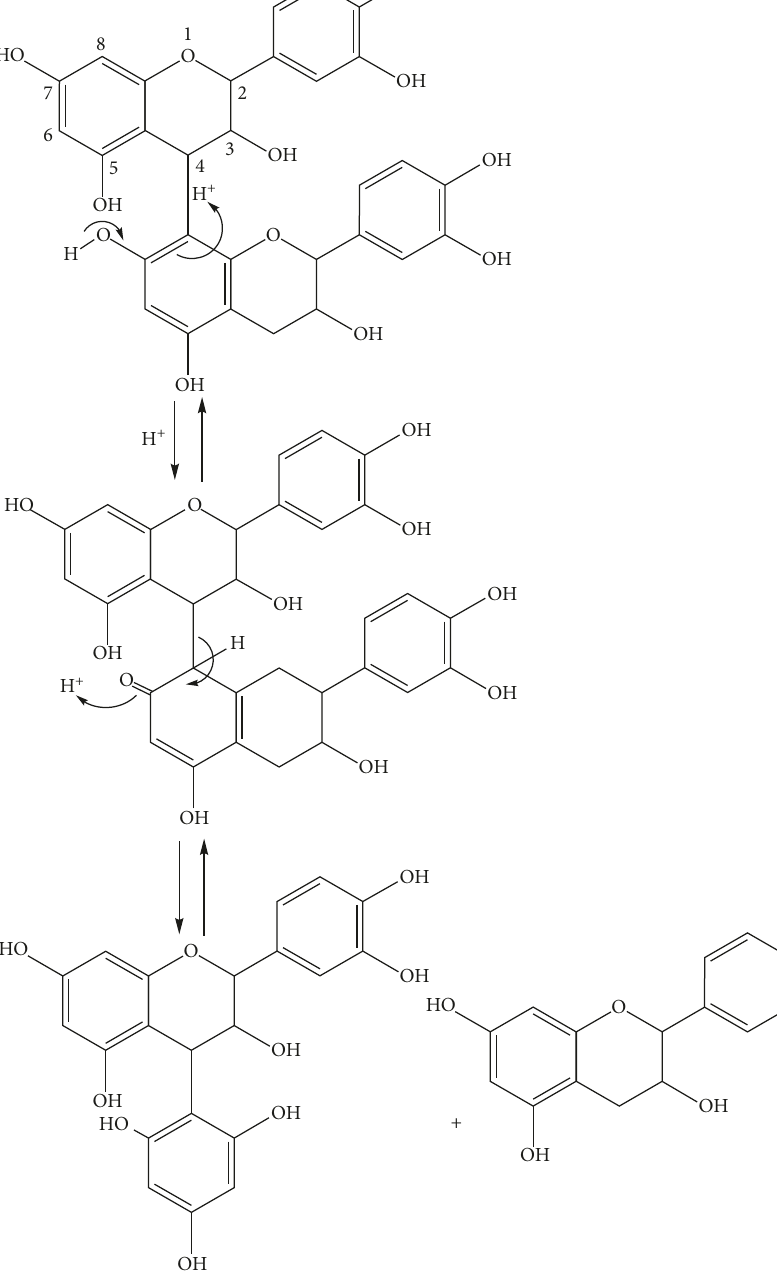
Figure 1: Reaction mechanism of acid-catalyzed hydrolysis in the presence of excess